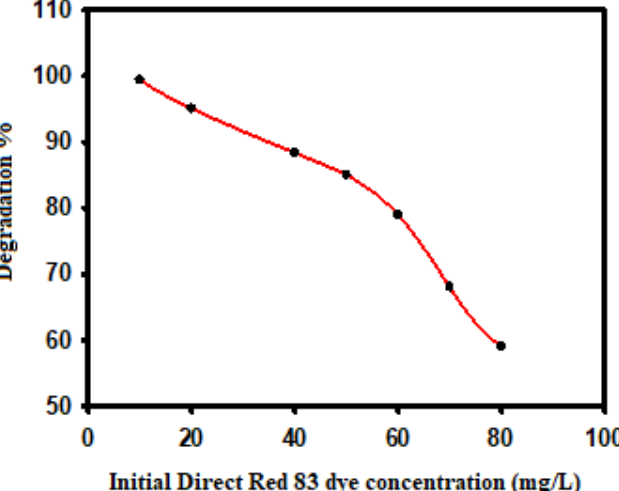
Figure 6. Effect of reducing agent content ( a ) 3 mL, ( b ) 4 mL and ( c ) 5 mL on the degradation of Direct Red 83 dye using 0.3 g of Ca-ALG/MgO/Ag nanocomposite beads catalyst with a dye concentration of 100 mg/L.